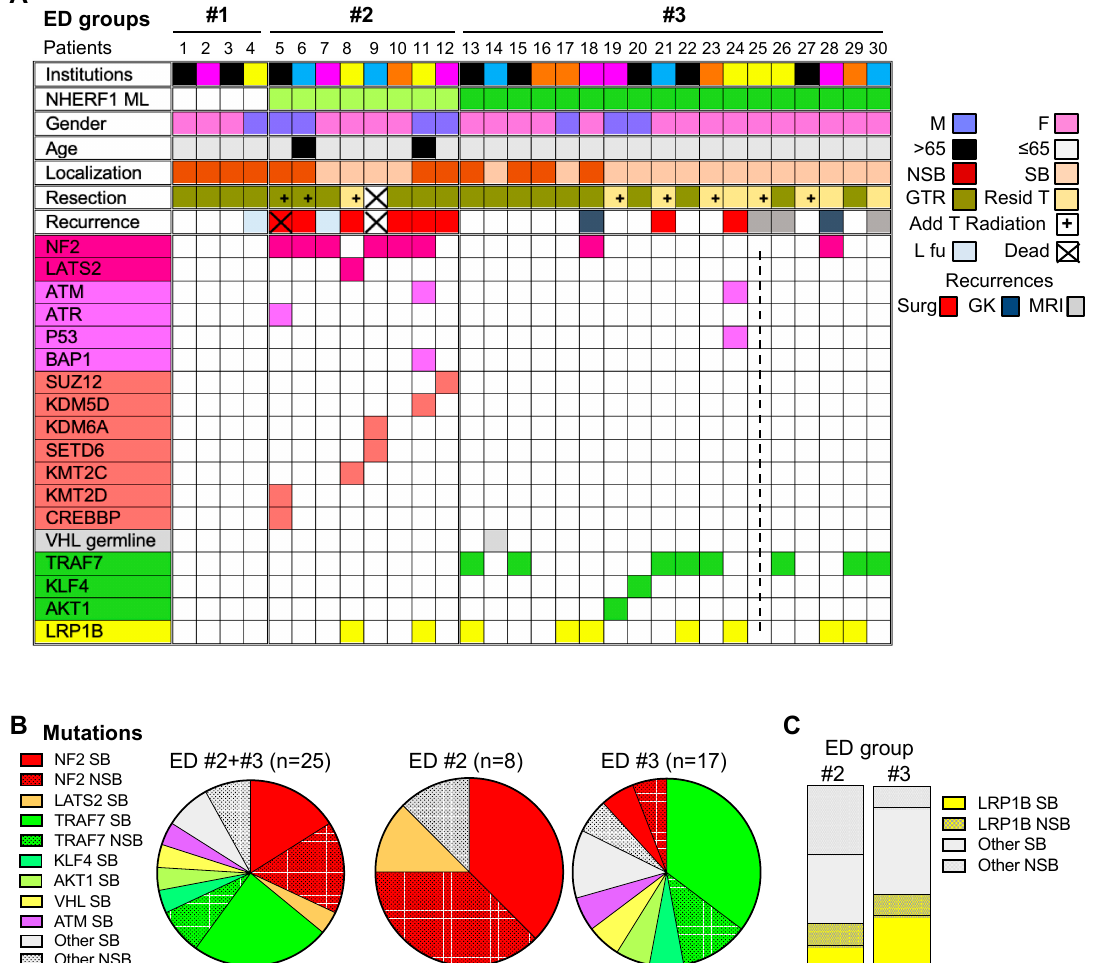
Figure 2. NHERF1 ED groups show distinct gene mutation profiles. ( A ) Comprehensive color-coded table in which columns correspond to individual patients/tumors ordered as in Figure 1B. Samples originating from the same institution have the same color. The genes within the same pathway are color-coded, except for TRAF7, KLF4, and AKT1, that are grouped together because of their frequent occurrence in SB tumors. The dotted line indicates the intraosseous tumor for which NGS could not be performed. M, male; F, female; GTR, gross total resection; Resid T, residual tumor; Add T radiation, additional tumor radiotherapy; L fu, lost to follow-up; Surg, surgery; GK, gamma knife; MRI, regrowth on MRI without any treatment. ( B ) Pie charts indicating the correspondence between the most prevalent gene mutations and tumor location. ( C ) Stack distribution of LRP1B mutations in tumors from ED groups #2 and #3.